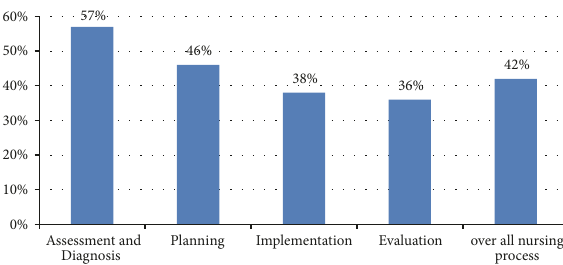
Figure 1: Nursing process implementation by its parts and overall as a process among nurses in Afar region hospitals, Afar, north East Ethiopia, 2016 (n=